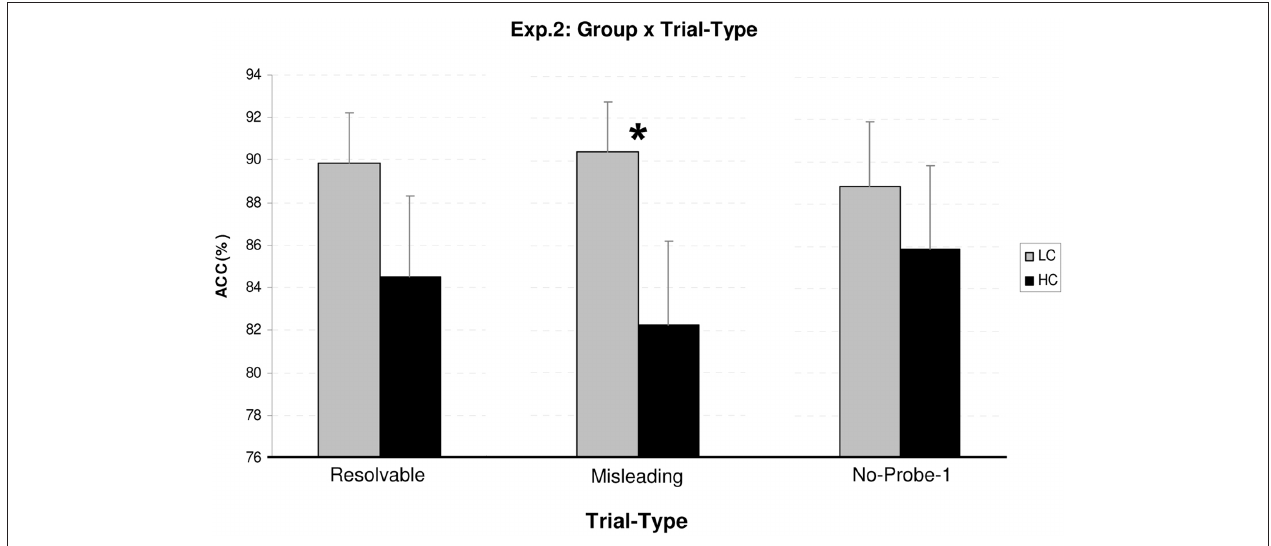
Figure 2 | Probe-2 accuracy (ACC%) for group (low vs. high) at each level of trial type (resolvable, misleading, no-probe-1). *Denotes significance at p <